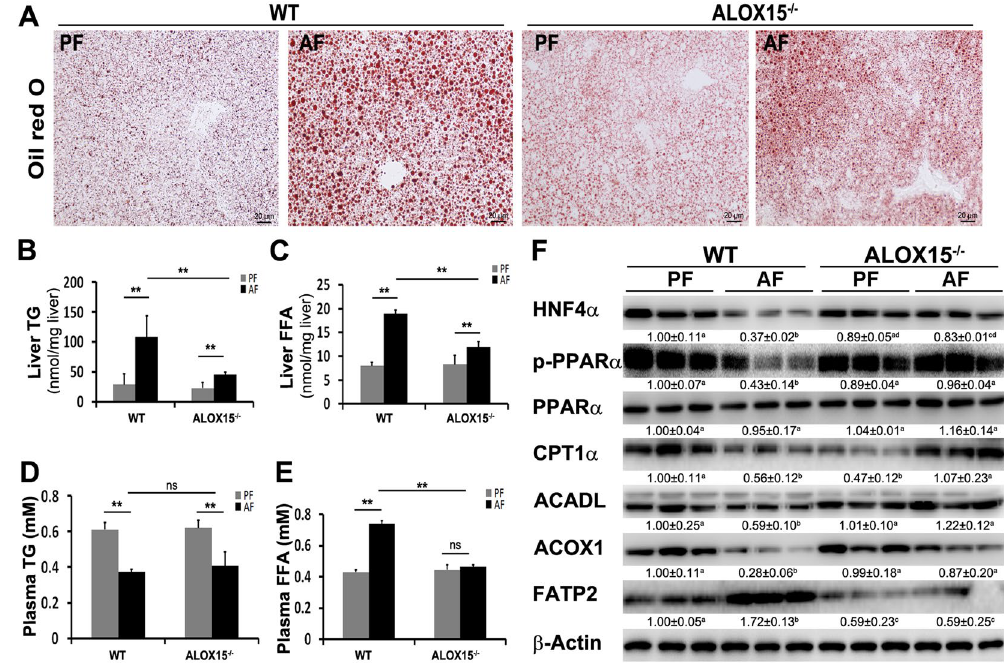
Figure 5. ALOX15 knockout attenuated alcohol-induced perturbation of lipid metabolism. WT and ALOX15 − / − male mice were fed with control (PF) or alcohol (AF) liquid diet for 8 weeks. ( A ) Representative image of Oil red O staining of liver sections. ( B ) Liver TG content. ( C ) Liver FFA concentration. ( D ) Plasma TG content. ( E ) Plasma FFA concentration. ( F ) Immunoblot of proteins involved in lipid metabolism. Protein levels were quantitated by NIH image J. All values are denoted as means ± SD (n = 6 in B-E, n = 3 in F). Significant differences were indicated by different letters (ANOVA, P < 0.05). * P < 0.05, ** P < 0.01, ns, not significant (t-test). TG: triglyceride, FFA: free fatty